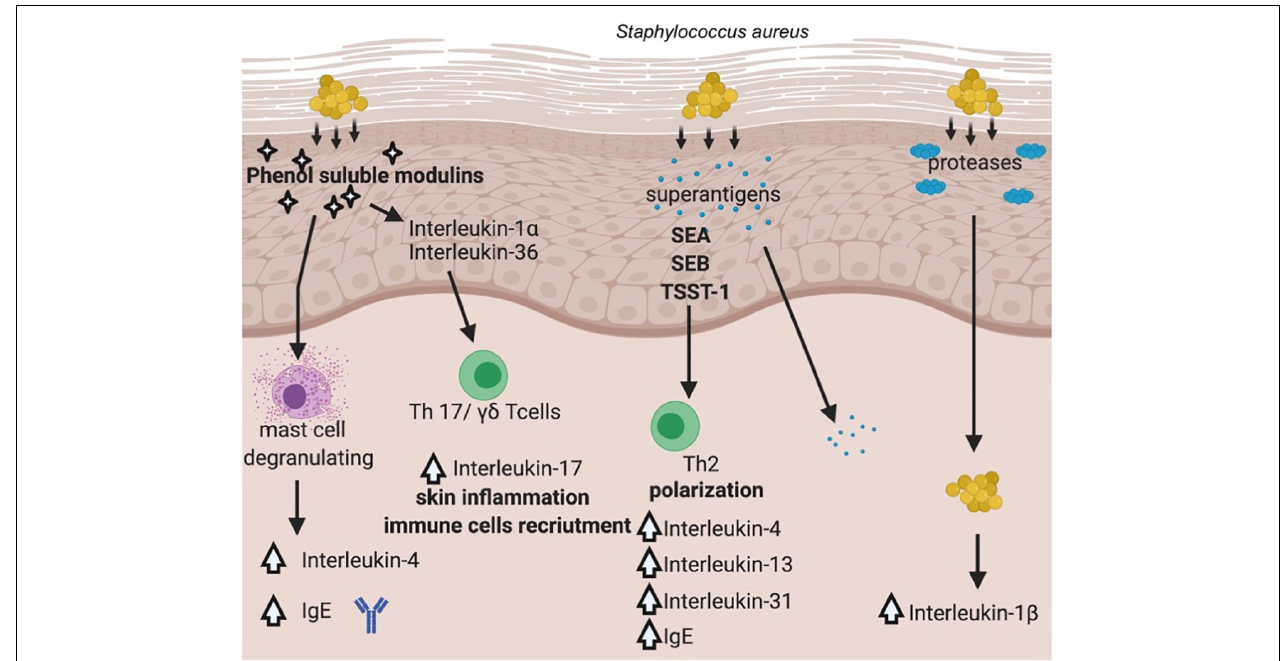
FIGURE 3 | Pathways involved in S. aureus ’ virulence factors contribution to AD. (Created with